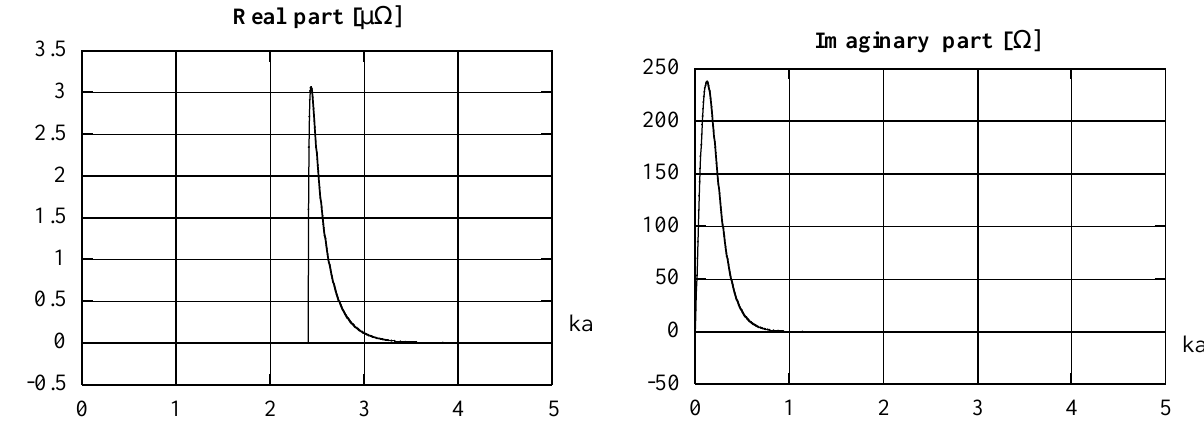
FIG. 6. Real and imaginary parts of the longitudinal coupling impedance in the case (cid:119) (cid:173) (cid:50) (cid:121) (cid:53) and bg (cid:173) (cid:49) (cid:121) (cid:49)(cid:48) .